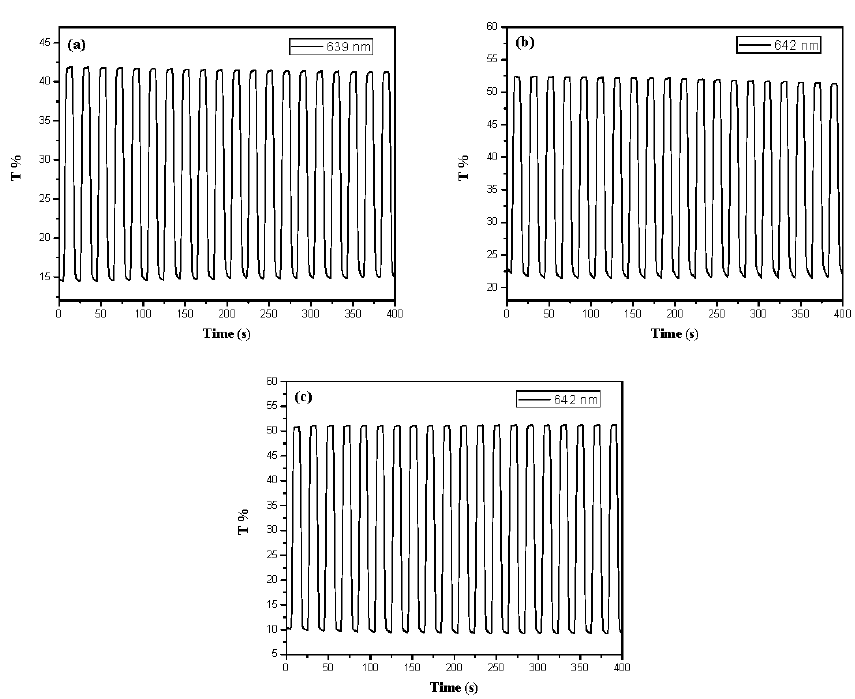
Figure 9. Optical contrast of ( a ) PBCz/double-layer PEDOT-PSS ECD; ( b ) P(BCz- co -ProDOT)/ double-layer PEDOT-PSS ECD; and ( c ) P(BCz- co -ProDOT)/triple-layer PEDOT-PSS ECD between 0.0 V and 2.0 V with a residence time of 10 s. Optical and electrochemical properties investigated at selected applied wavelength for the ECDs.